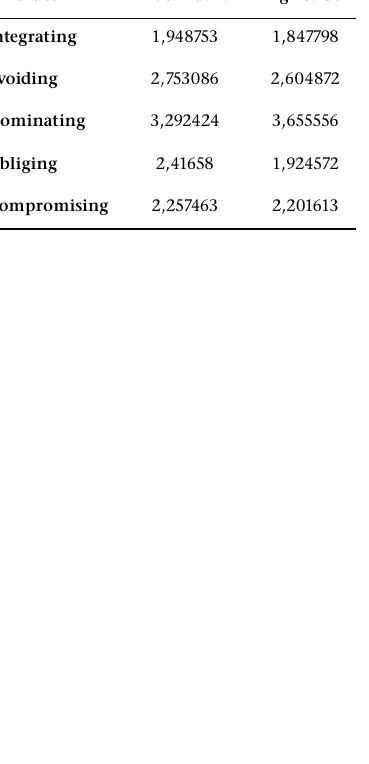
Figure 1: Comparative analysis of respondent conflict with superior in both